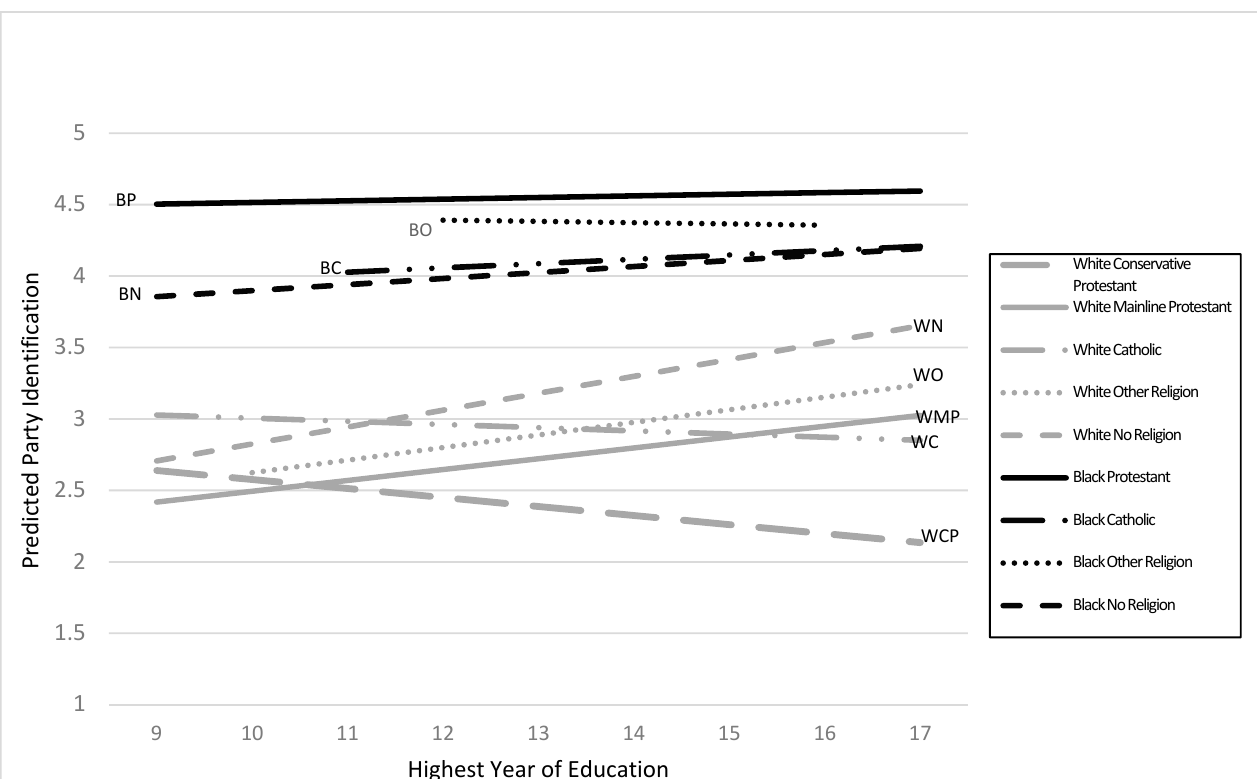
Figure A4. Party identification by race, religion, and education, Pew 2014 Religious Landscape Survey.